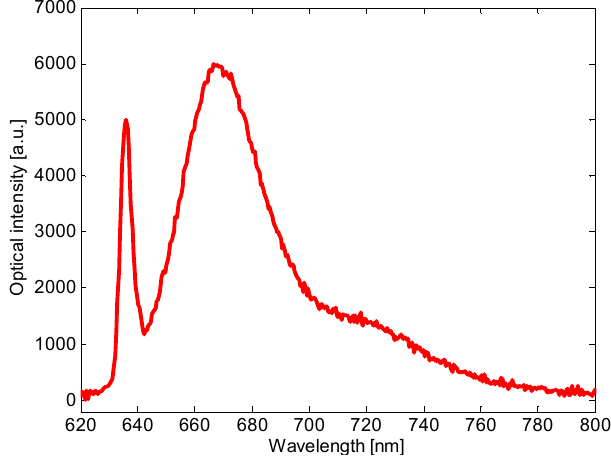
Figure 10. Fluorescence spectrum collected for a Cy5 concentration 6.76 × 10 − 6